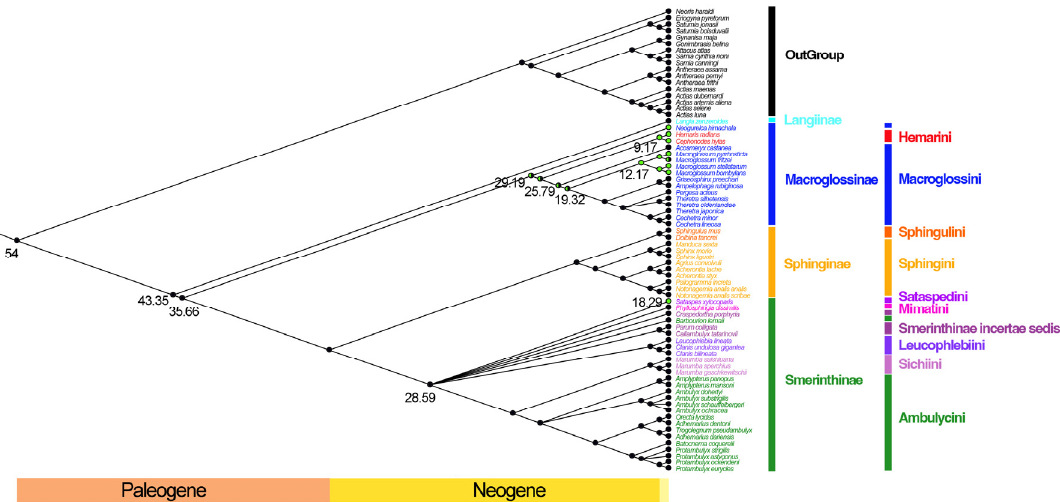
Figure 4. Ancestral state reconstruction on the phylogenetic tree based on PCG12 dataset. The number on the node indicates the estimated time of differentiation. Adult lifestyle was defined and is indicated as follows: (1) diurnal behavior (green dots); (2) nocturnal behavior (black dots); (3) both diurnal and nocturnal behavior (half black half green dots).